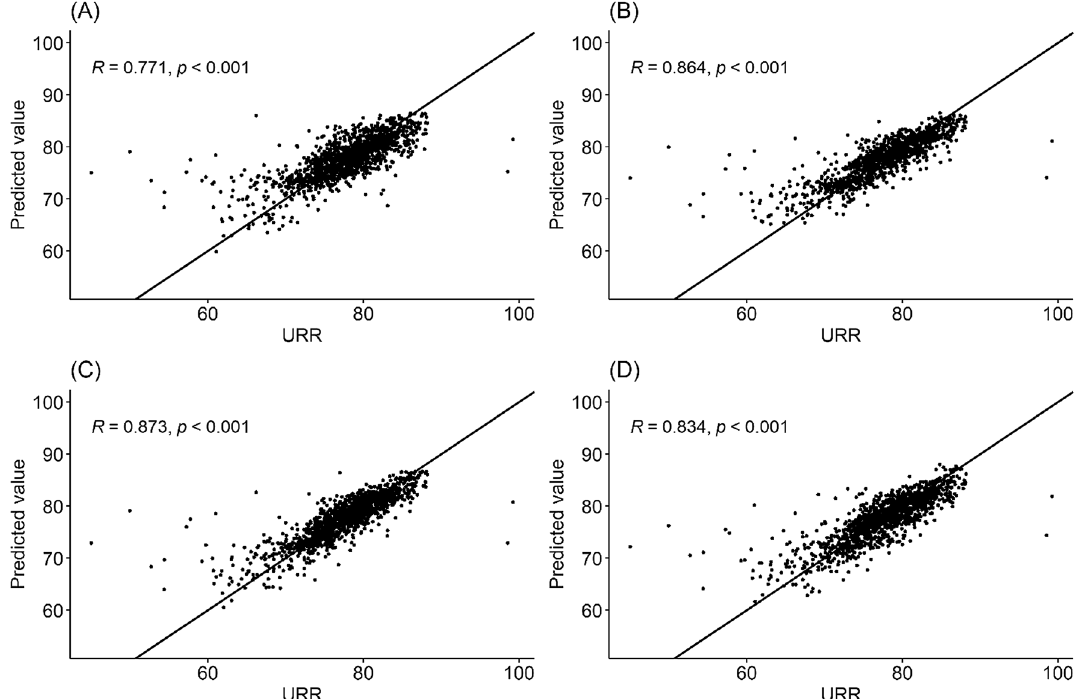
Figure 1. Scatter plots of URR and the predicted value for each model using Spearman’s rank correlation coefficient and the best fit line. ( A ) Linear regression ( R = 0.771). ( B ) Random forest ( R = 0.864). ( C ) XGBoost ( R = 0.873). ( D ) Deep learning with convolutional neural network ( R = 0.834). URR urea reduction ratio, XGBoost extreme gradient